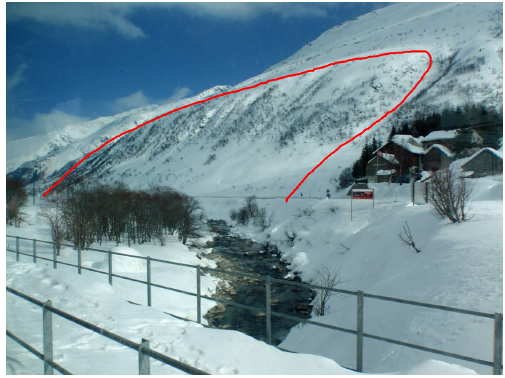
Figure 12. Avalanche path of the Böschen avalanche. The red line demarcates the lower release zone, which produces frequent avalanches affecting the road.